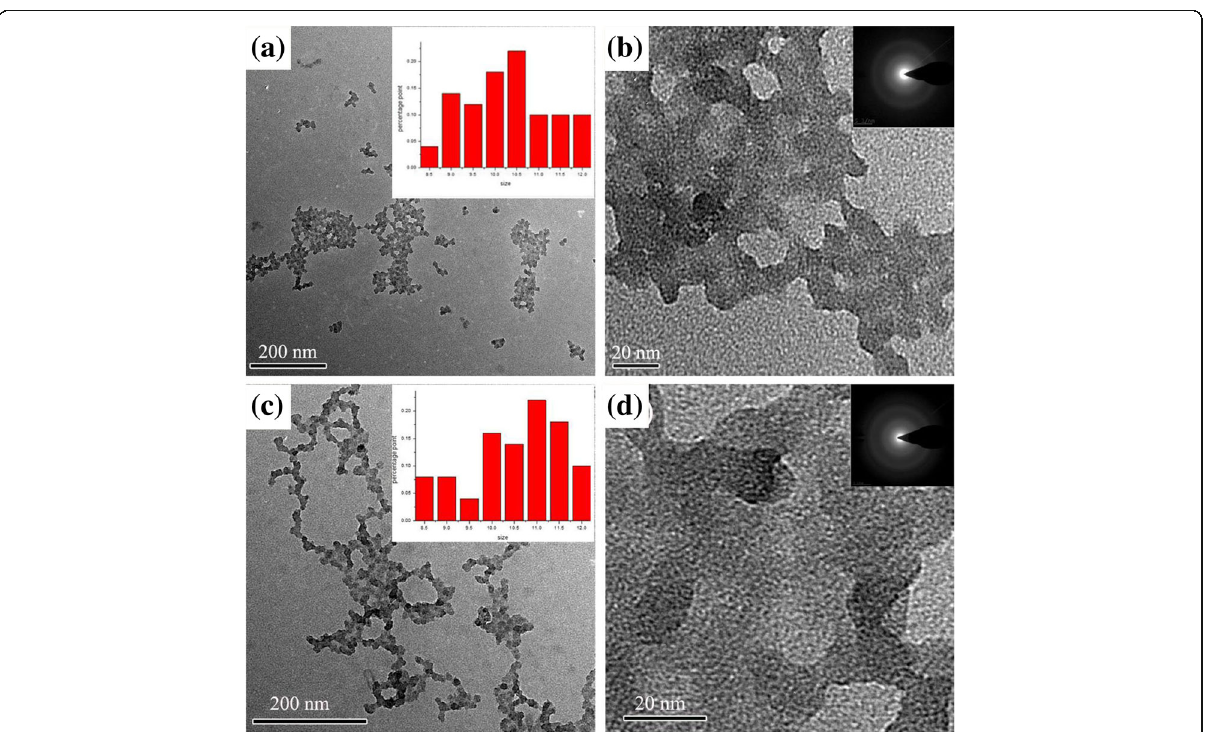
Fig. 1 a Low-magnification TEM images of silica sol C. b High-magnification TEM images of silica sol C. c Low-magnification TEM images of silica sol D. d High-magnification TEM images of silica sol D. Insets in images are the corresponding grain size distribution histogram and SEAD